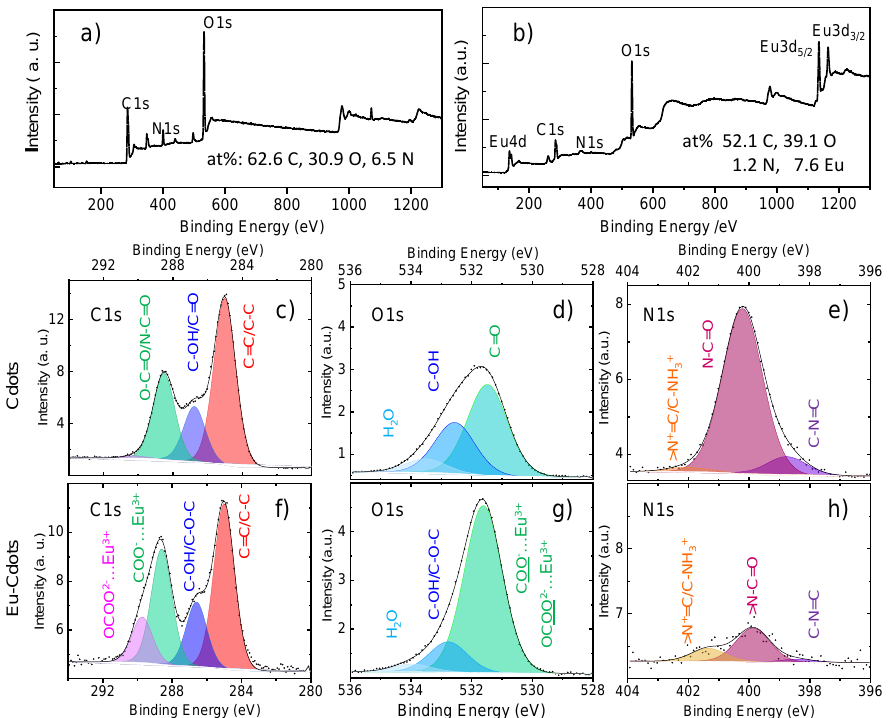
Figure 2. XPS spectra of the Cdots and Eu-Cdots: low resolution XPS spectra ( a , b ) and high resolution XPS spectra for the C1s, O1s, and N1s peaks of the Cdots ( c – e ) and Eu-Cdots ( f – h ). The XPS spectrum of Eu-Cdots (Figure 2b) shows the peaks characteristic of Eu 3+ at 1135 eV (Eu3d 5/2 ), 1165 eV (Eu3d 3/2 ), and 137 eV (Eu 4d) in addition to the peaks of C1s, N1s, and O1s around 285, 400, and 532 eV, also present in the Cdots (Figure 2a). The atomic percentages calculated based on the area of the peaks are indicated in Figure 2. The results show that the Eu-Cdots have a higher percentage of oxygen and a lower percentage of nitrogen (39.1% O and 1.2% N) than the Cdots (30.9% O and 7.6% N) that we attribute to the high affinity of Eu 3+ to the carboxylic groups of citric acid and carbonyl groups of urea favoring the retention of oxygen during the formation of the carbon net- work.